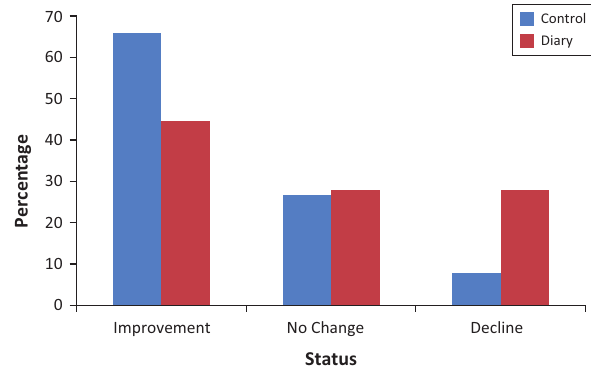
FIGURE 6: Weight for height z -score response at 12 months for both